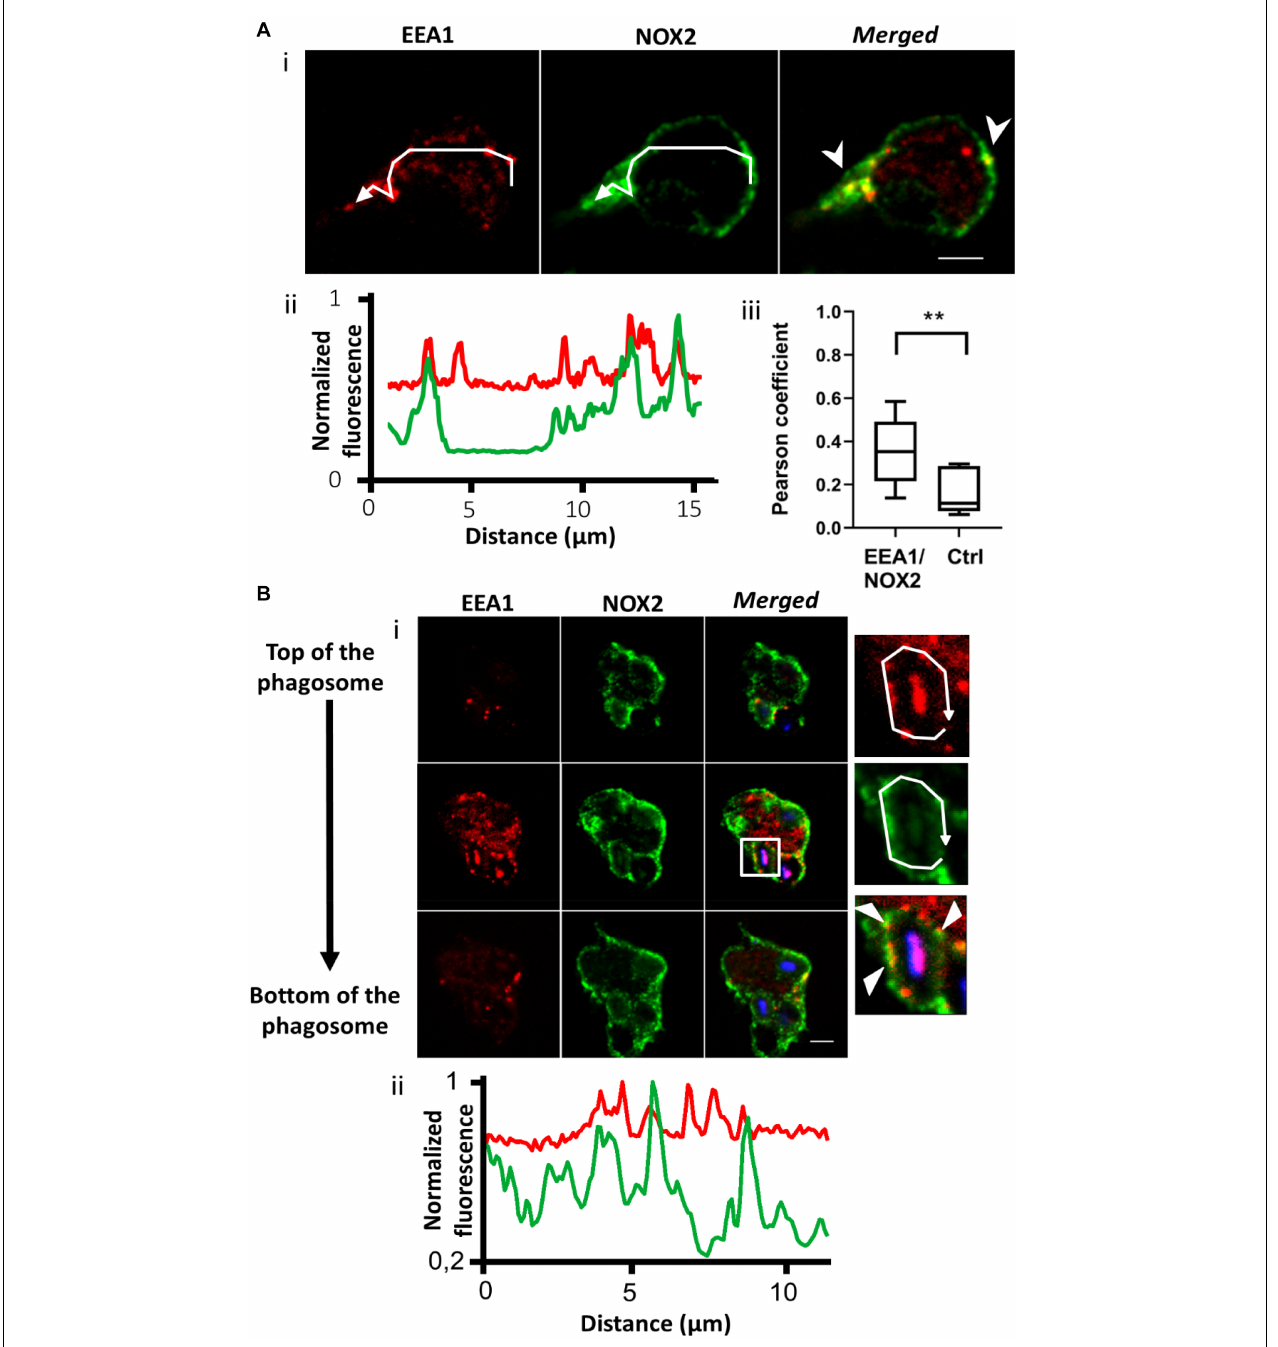
FIGURE 2 | NOX2 is present in some EEA1-positive endosomes that localize close to the phagosome during phagocytosis. (A) EEA1 (red) and NOX2 (green) were detected by immunofluorescence in resting PLB-985 WT cells using spinning disk confocal microscopy. (Ai) Representative images of single planes from a Z-stack. Scale bar = 3 µ m. Three independent experiments. (Aii) Normalized fluorescence of EEA1 and NOX2 along the white arrow shown in Ai . Overlapping peaks of fluorescence indicate localization of NOX2 and EEA1 in the same structures. (Aiii) Co-localization of EEA1 and NOX2 estimated using the Pearson coefficient (PC) calculated with the JACoP plug-in in Image J. PCs correlating EEA1 and NOX2 images (EEA1/NOX2) were controlled by comparison with the PCs correlating the EEA1 image and the image of NOX2 rotated by 180 ◦ (Control, Ctrl). Eight images from three independent experiments were analyzed. Each boxplot represents the inter-quartile range with the median, ** represents p < 0.01 (Mann Whitney test). (B) EEA1 (red) and NOX2 (green) were detected by immunofluorescence after 10 min of phagocytosis with opsonized Texas Red-zymosan. (Bi) Three planes from a series of Z-stack planes (0.5 µ m). Some EEA1 endosomes were observed close to or at the phagosomes. Scale bar = 3 µ m. Three independent experiments. (Bii) Normalized fluorescence of EEA1 and NOX2 along the white arrow showing some overlapping peaks of NOX2 and EEA1 fluorescence at the phagosome.